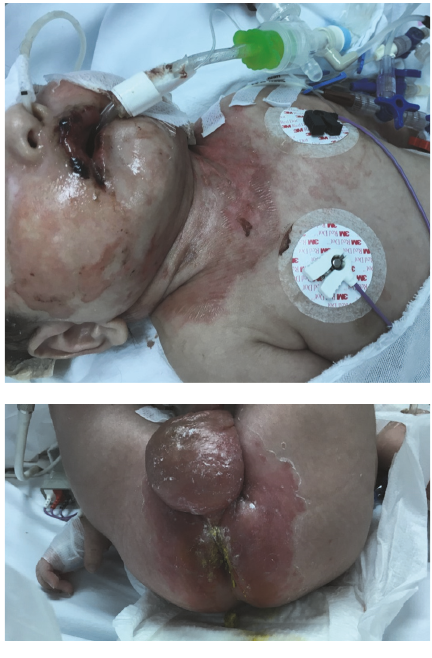
Figure 2: Skin lesions in the perioral, cheeks, neck, upper anterior chest wall, and perianal regions seen in an MSUD infant with isoleucine